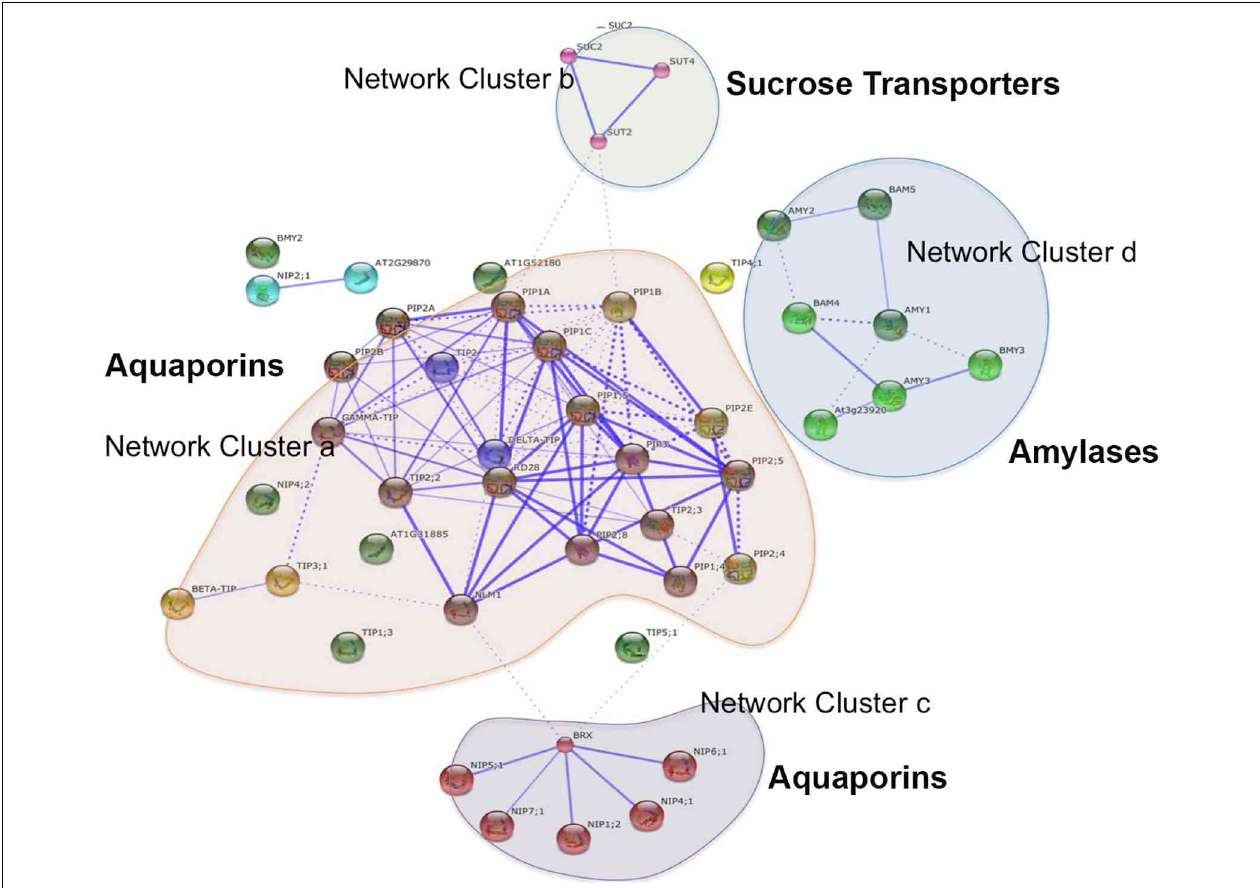
FIGURE 3 | The protein-protein interaction network of Arabidopsis sucrose transporters, amylases and aquaporins, generated using String database. Thicker lines indicate stronger reaction (Szklarczyk et al.,